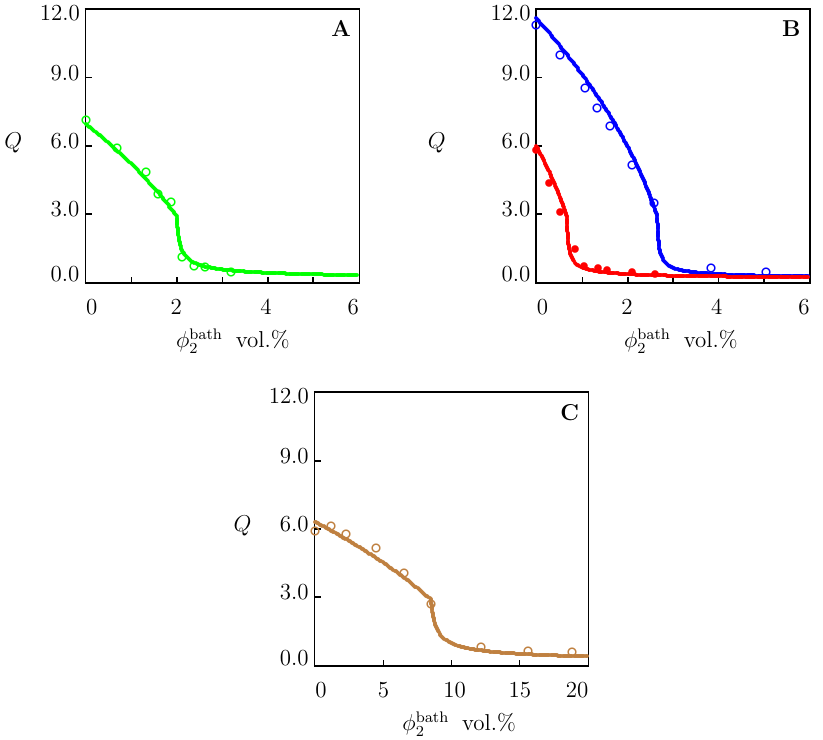
Figure 5. Equilibrium degree of swelling Q versus concentration of additive φ bath solutions. Circles: experimental data on PNIPAAm gel [42] in aqueous solution of NaCl ( A ) and NaOH ( B ) at T = 25 ◦ C. Solid lines: results of numerical analysis.